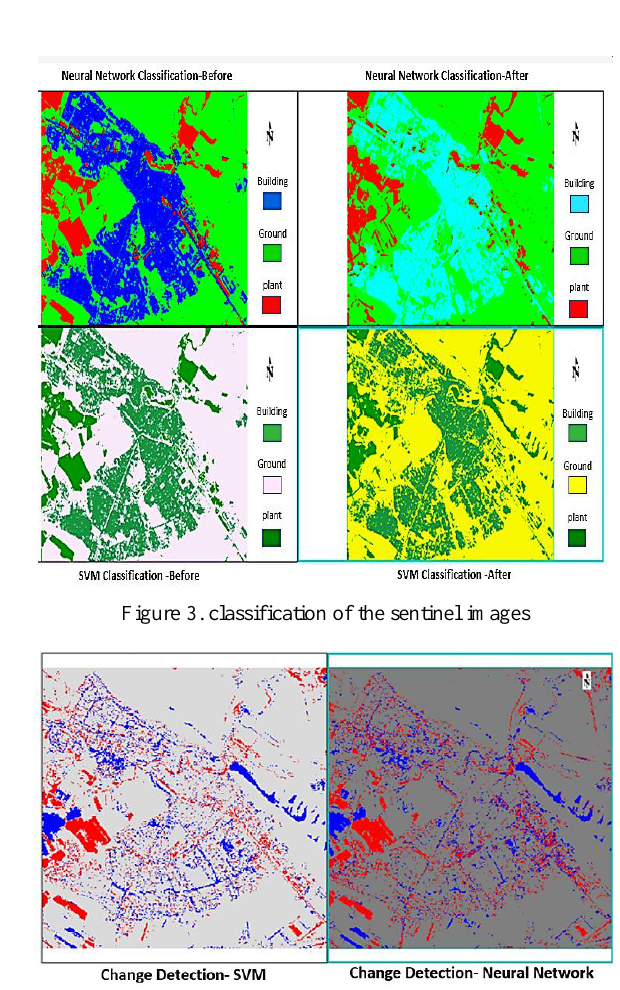
Figure 4. Change Maps